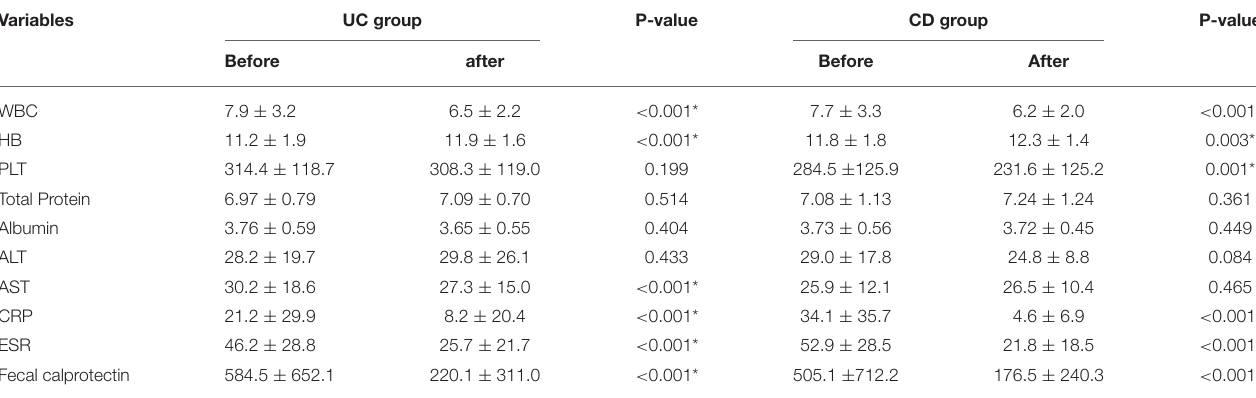
TABLE 3 | Laboratory characteristics of patients with inflammatory bowel disease in Egypt (May 2018 to August 2021) before and after treatment.